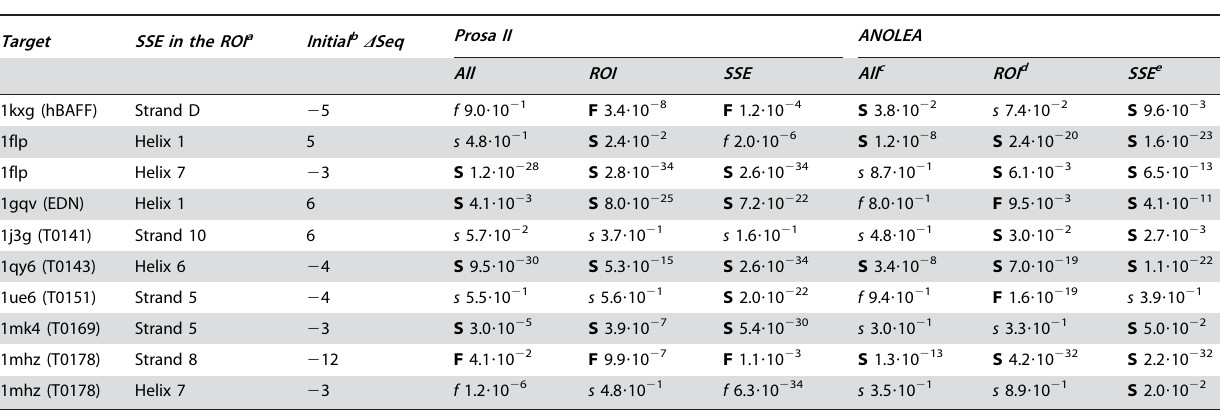
Summary of alignment refinement results for our set of test cases using two scoring functions based on potential of mean force combined with three different residues selections, as well as the associated p-values (see text for details). F stands for failure and S for success. When the p-value associated with the prediction is significant, the outcome is formatted in bold character, otherwise in lowercase italic. a Secondary structure element (SSE) in the region of interest (ROI) (see Table 1 for more details about the ROI). b Offset between the initial target-template alignment (see Material and Methods) and the structural alignment. The reference is the structural alignment ( D Seq=0). A shift of the target SSE sequence to the C-terminal part (N-terminal) has negative (positive) value. c Prediction based on All residues selection. d Prediction based on ROI Local residues selection. e Prediction based on SSE Local residues selection. doi:10.1371/journal.pone.0002645.t003 PLoS ONE |